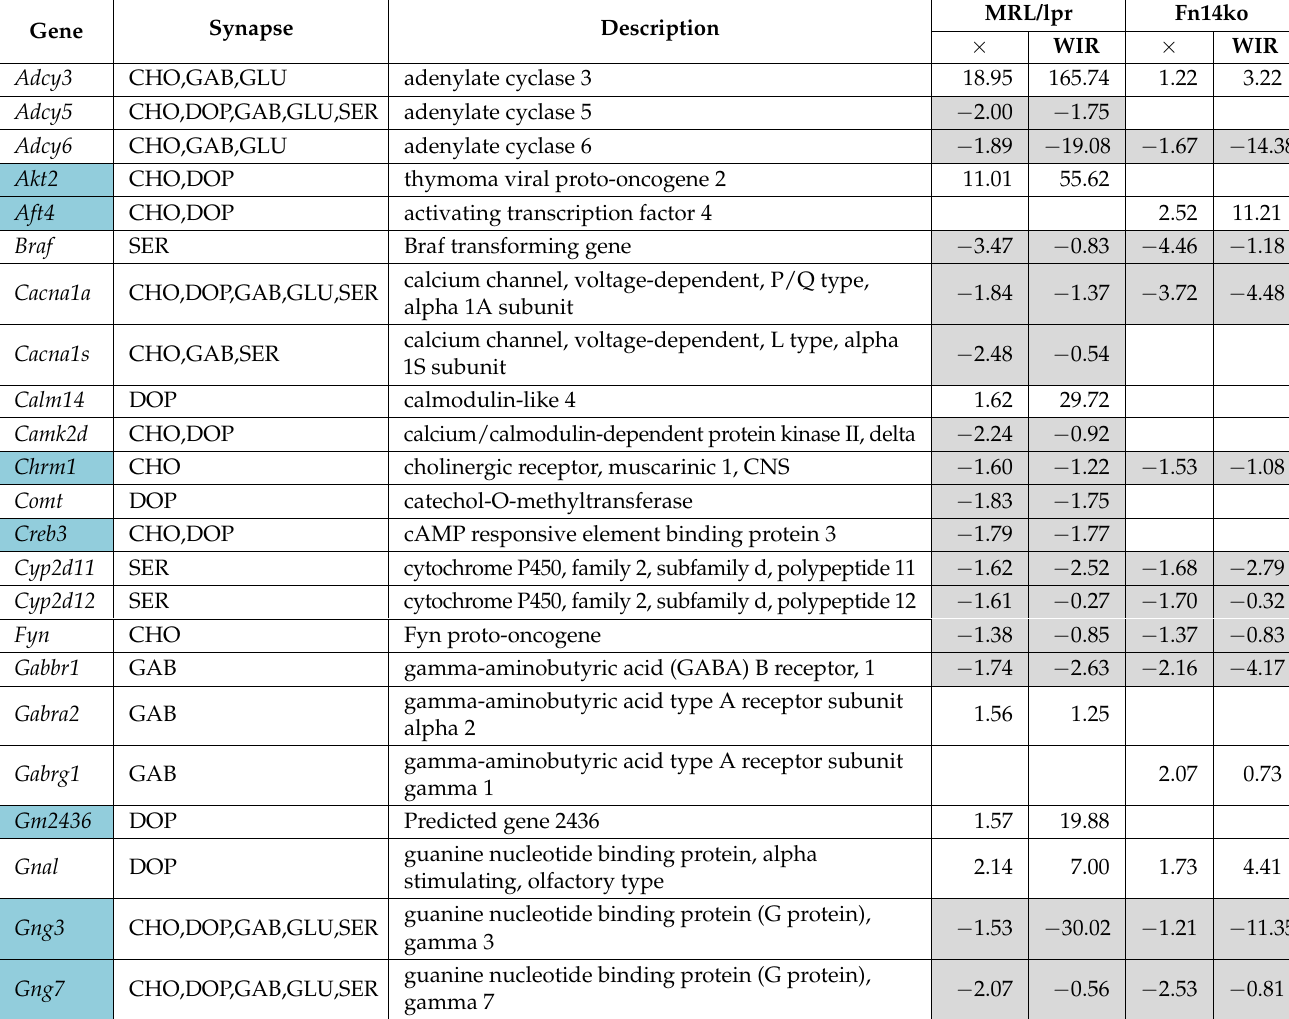
Table 1. Regulation of the Kyoto Encyclopedia of Genes and Genomes (KEGG)-determined neurotransmission genes in MRL/ lpr and Fn14ko compared with background controls. GLU, glutamatergic; GAB, GABAergic; CHO, cholinergic; DOP, dopaminergic; SER, serotonergic; x, expression ratio; WIR, weighted individual (gene) regulation. Blue background of gene symbols indicates regulated neurotransmission genes that are also involved in the PI3K-AKT signaling pathway, while grey background indicates down-regulation (negative fold-change and WIR) in the indicated